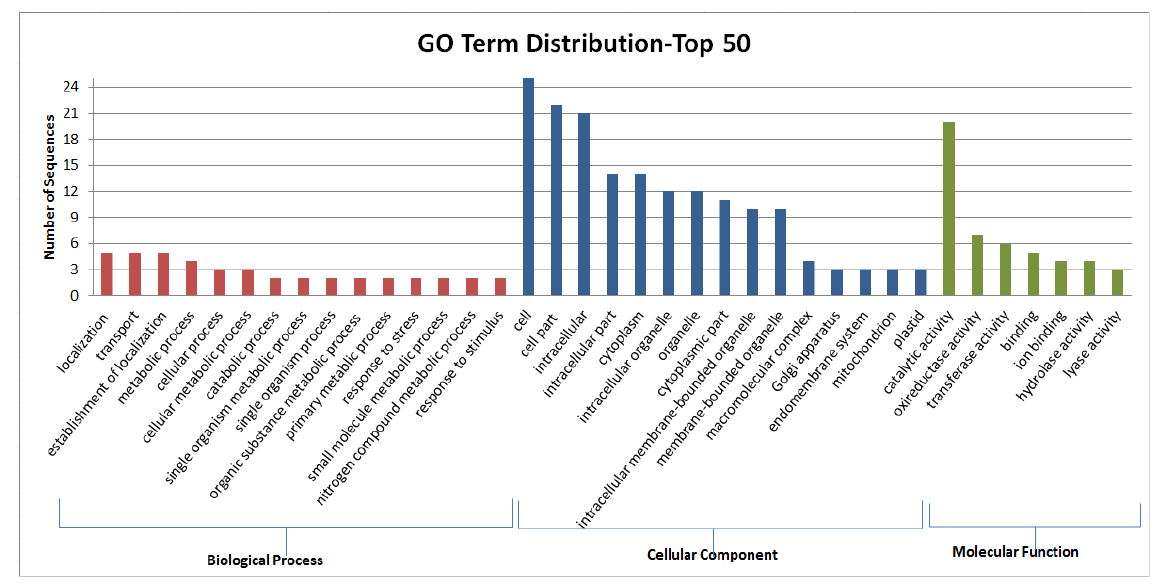
Figure 4: GO term distribution over the target sequences for top 50 GO